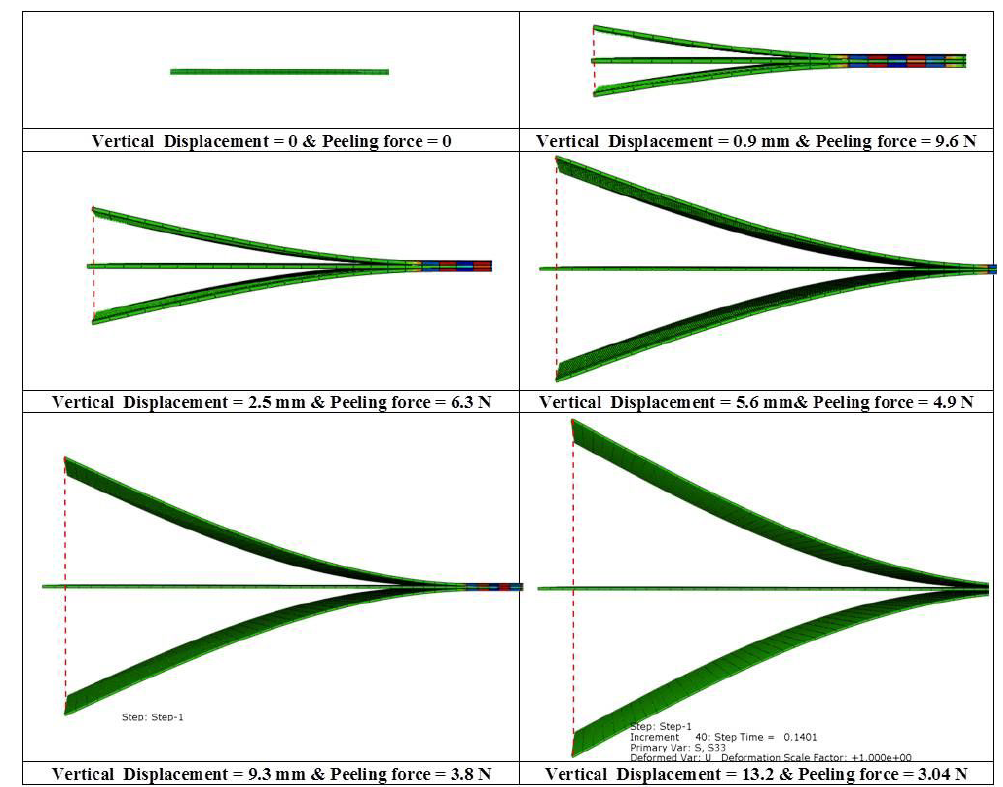
Figure 14. Horizontal movement of the specimen with respect to the axe of the loading.